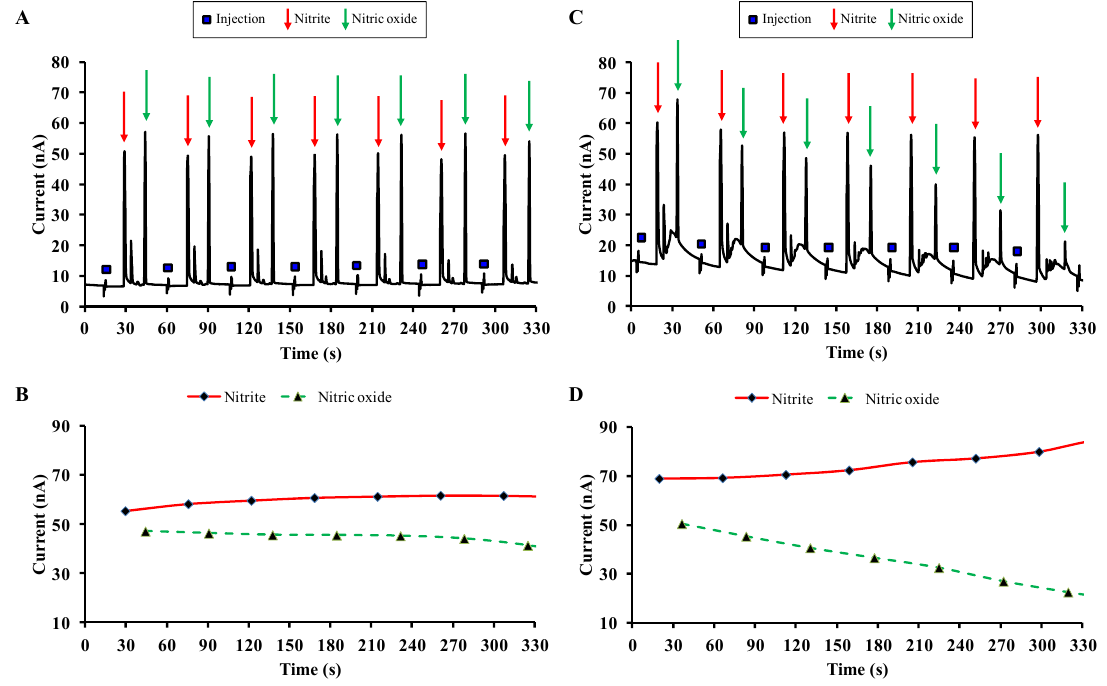
Figure 4. Detection of NO and NO 2 − in a cell-free system using ME-EC. ( A , B ) show a representative electropherogram and the quantification (peaks’ height) of NO and NO 2 − in a solution containing the NO donor DEA / NO in the absence of carnosine, while in ( C , D ) carnosine is present in the solution.